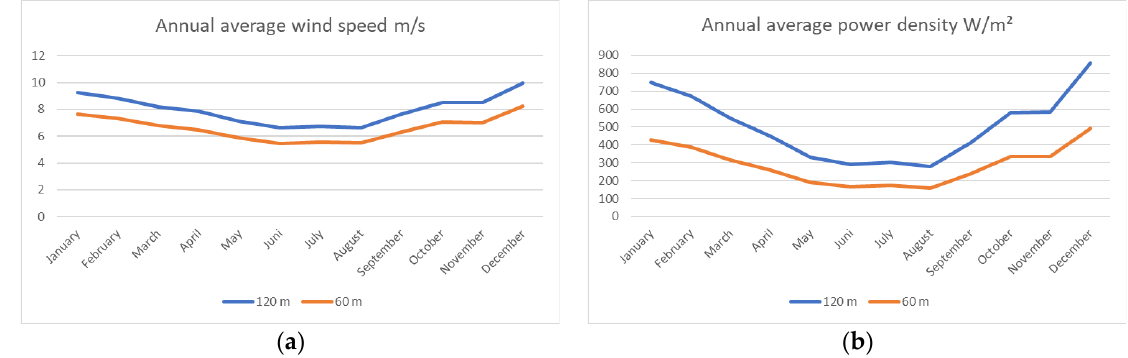
Figure 2. Average monthly amount of solar energy per square meter at the installation site: ( a ) GAfRE; ( b ) PVGIS.